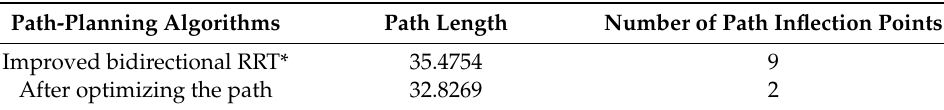
Table 1. Comparison of improved RRT algorithm and optimized